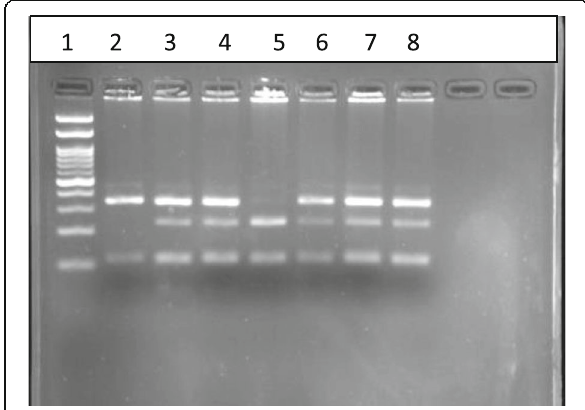
electrophoresis. Molecular weight marker (100 bp) (lane 1). Wild phenotype: If DNA is cut as 2 bands at 329 and 104 base pair (case 1) (lane 2). Mutant homozygous phenotype: If DNA is cut as 2 bands at 222 and 107or 104 base pair (case 4) (lane 5). Mutant 107 or 104 base pair (case 2, 3, 5, 6, 7) (lanes 3, 4, 6, 7, 8)